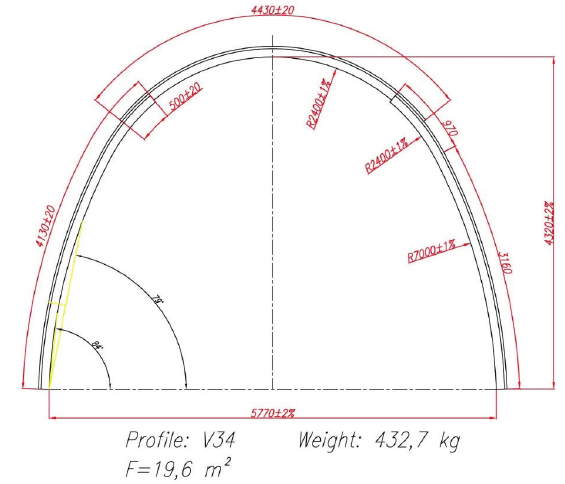
Figure 4: The proposed outline of the frame of approximately 20 m 2